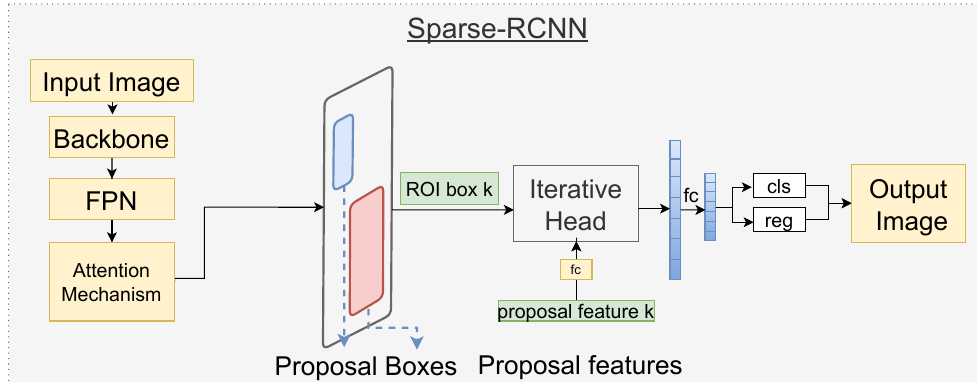
Figure 4. Flow diagram of page object detection with Sparse-RCNN in detail. Sparse-RCNN takes features from DyHead, and learns and proposes the optimal Region of Interest (ROI) boxes for the features, instead of a Region Proposal Network (RPN). The features are concatenated with latent proposal features, passed as FC layers, to predict and classify the